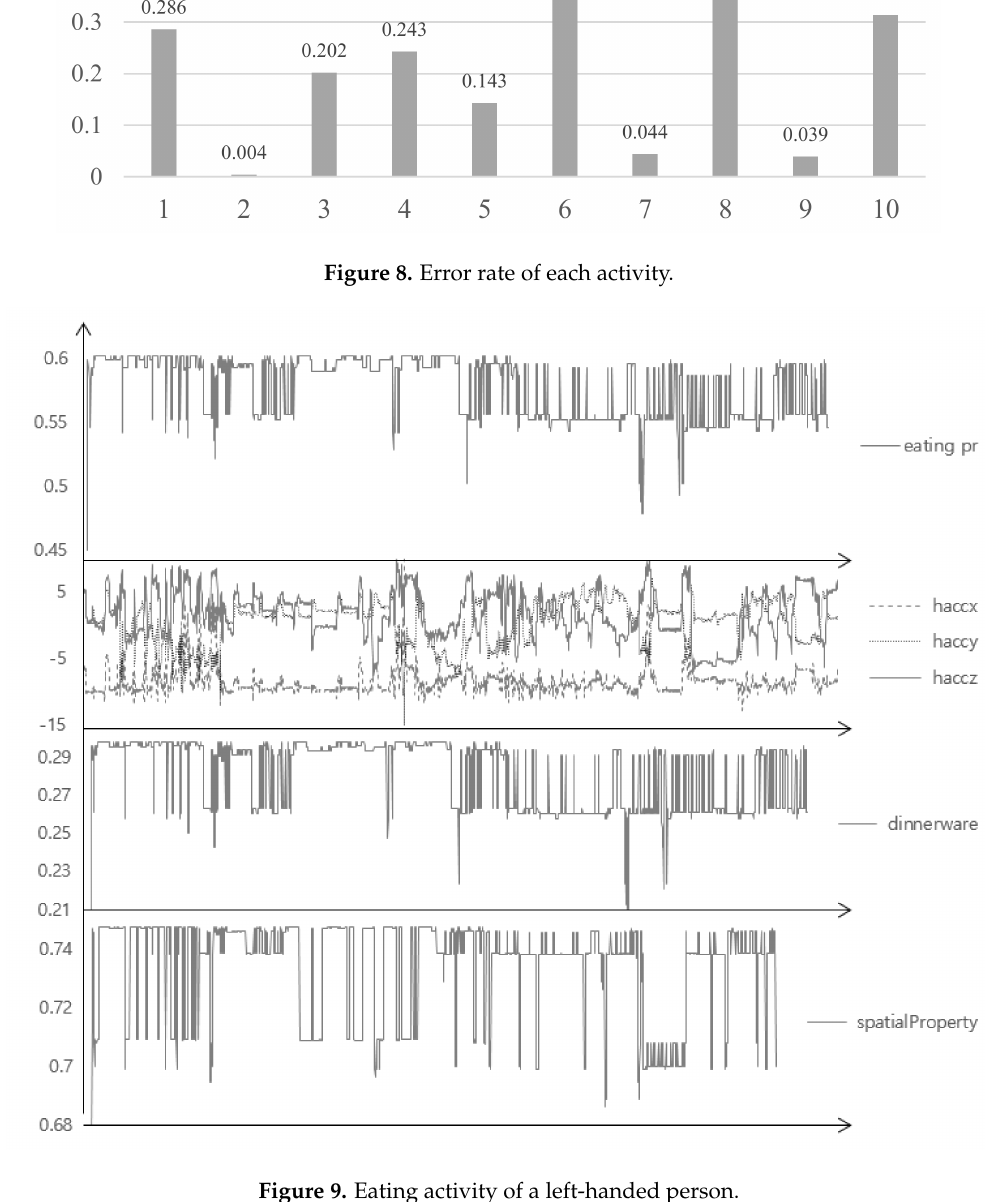
Figure 9. Eating activity of a left-handed